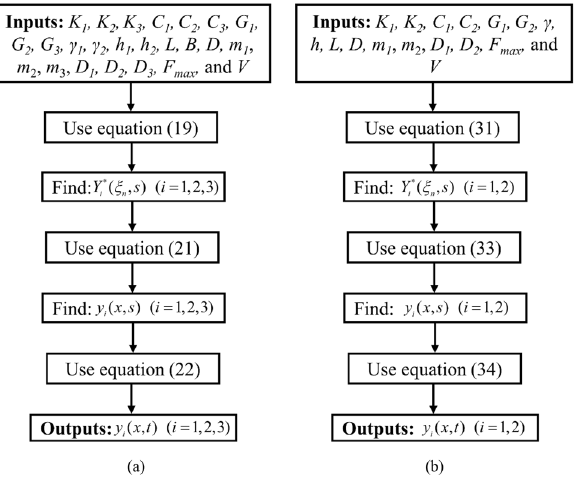
Figure 2. Flowchart of the proposed methodology ( a ) with safeguard and ( b ) without